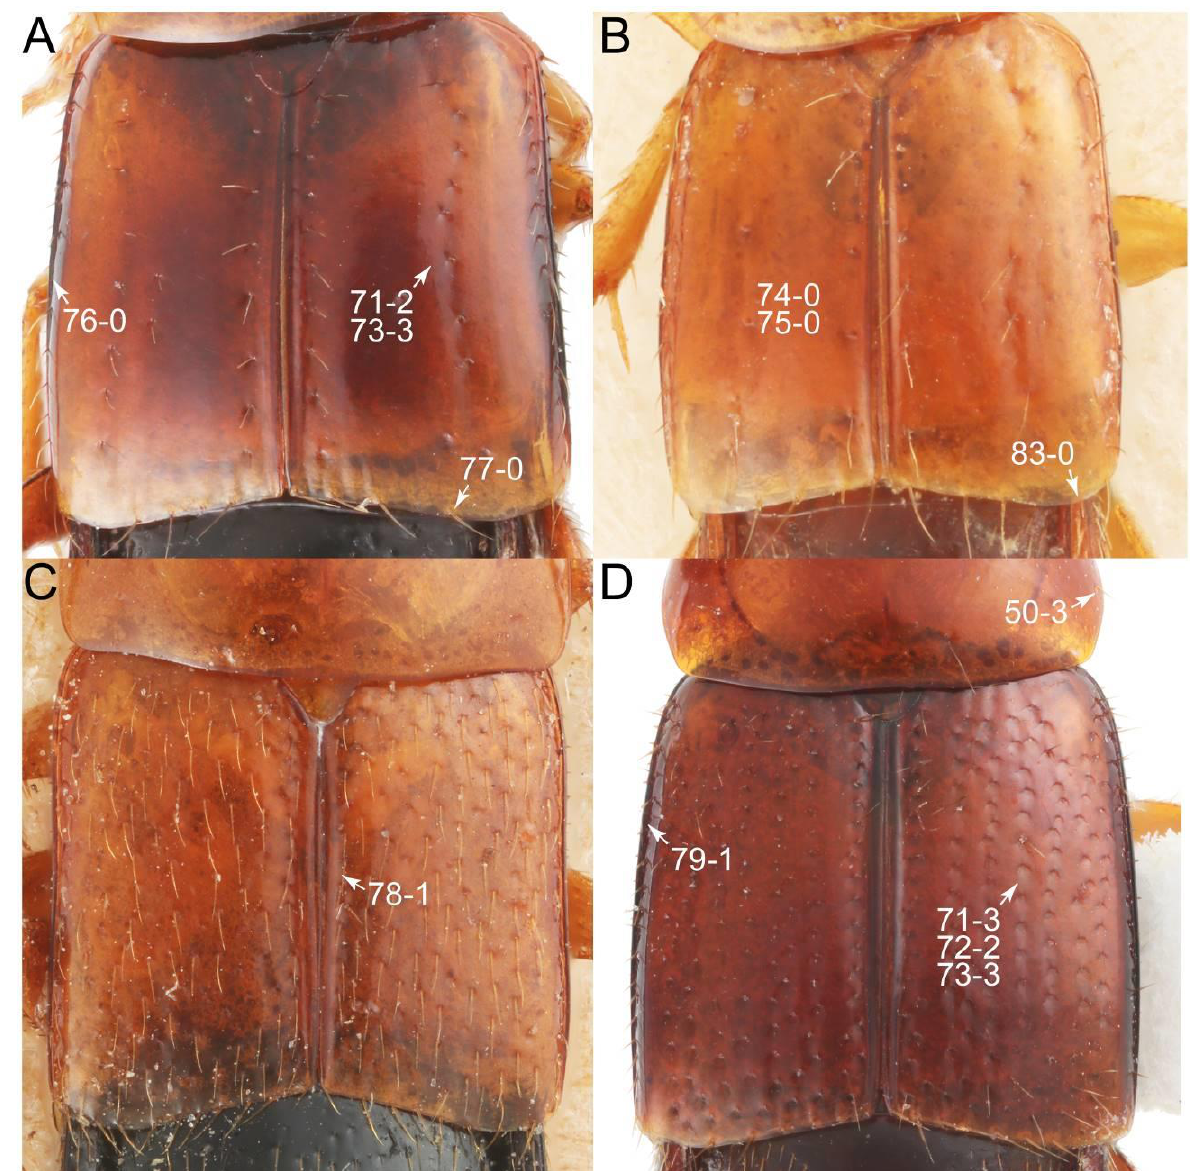
Figure 65. Photographs of body parts of Mycetoporinae, elytra, enlarged, dorsal view. ( A ) Mycetoporus punctus . ( B ) Ischnosoma splendidum . ( C ) Parabolitobius formosus . ( D ) Bryoporus rufescens . Characters and character states (format X-X) are indicated on each